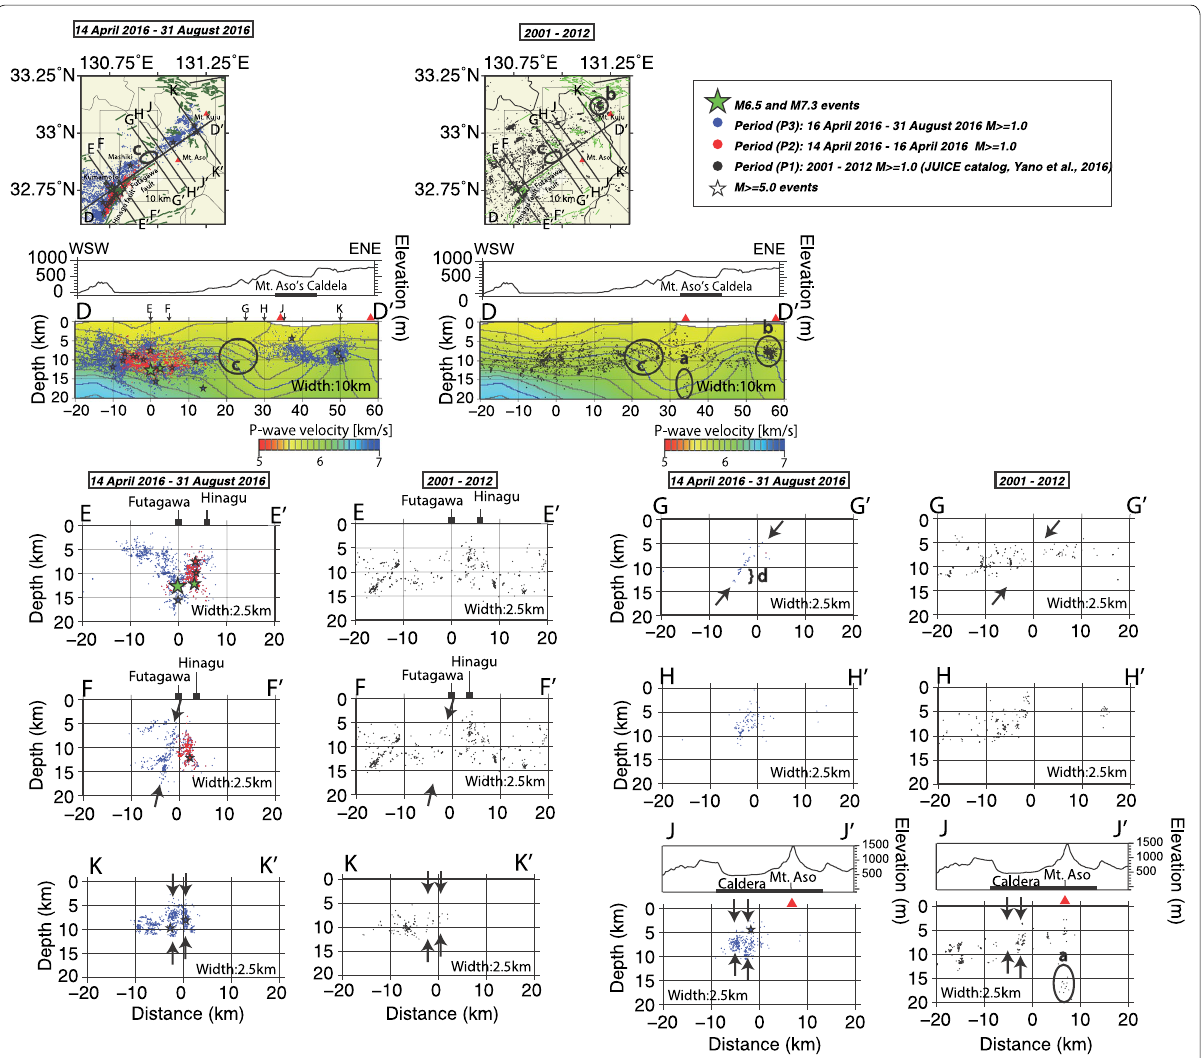
Fig. 3 Relocated hypocenters distribution and cross sections within the subregions (SR2), (SR3), and (SR4). The cross section along D – D ′ is pro- jected onto seismic velocity study (Matsubara and Obara 2011) and elevation. The cross section along J – J ′ is superimposed with elevation. The background-relocated hypocenters between 2001 and 2012 (JUICE catalog) in black dots are accompanied on the left with corresponding relocated hypocenter distribution and cross sections. These cross sections follow the Futagawa fault zone and extend to northern boundary of the Aso